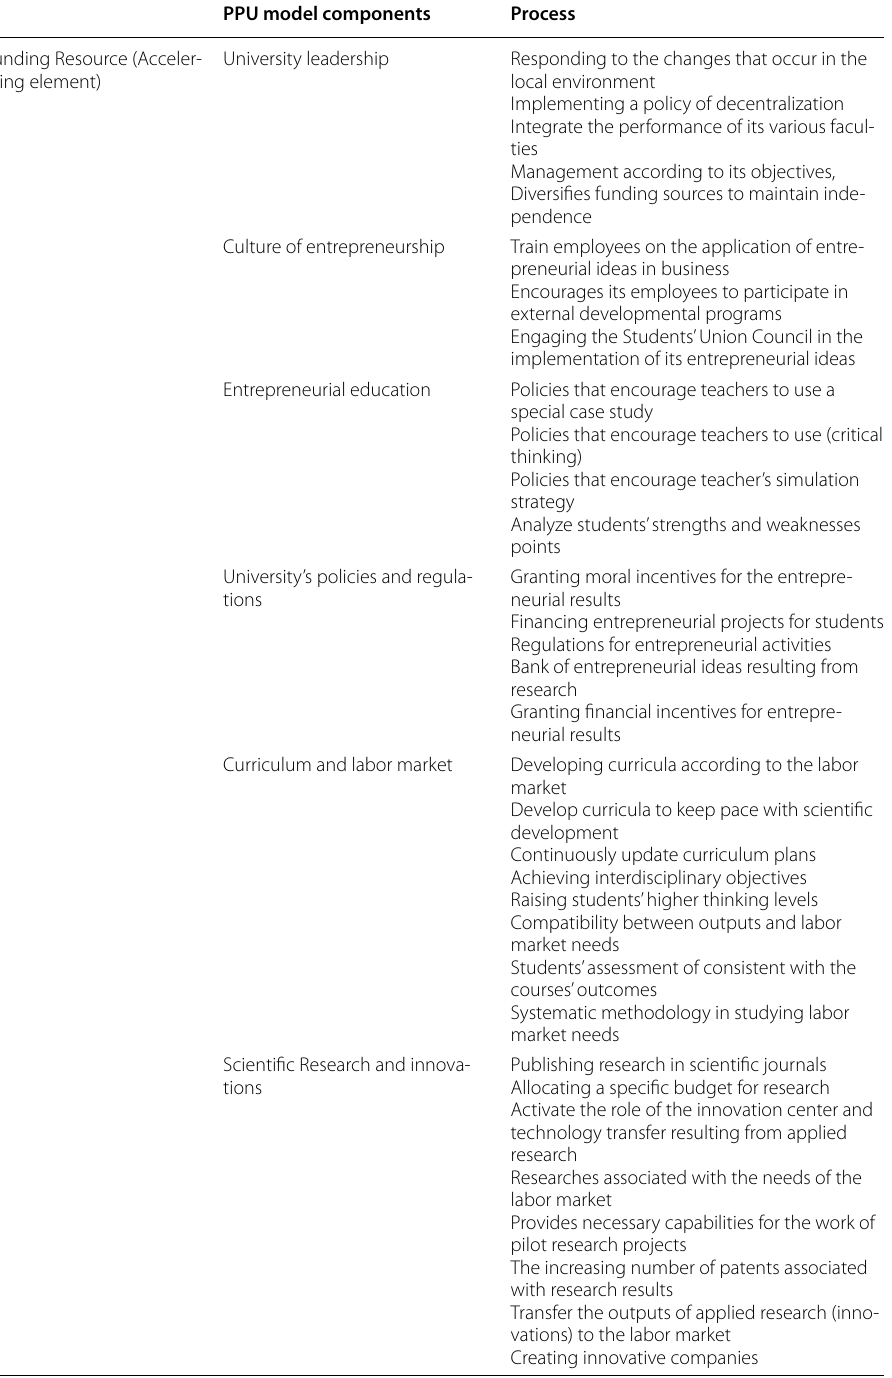
Table 6 Process to develop entrepreneurship at